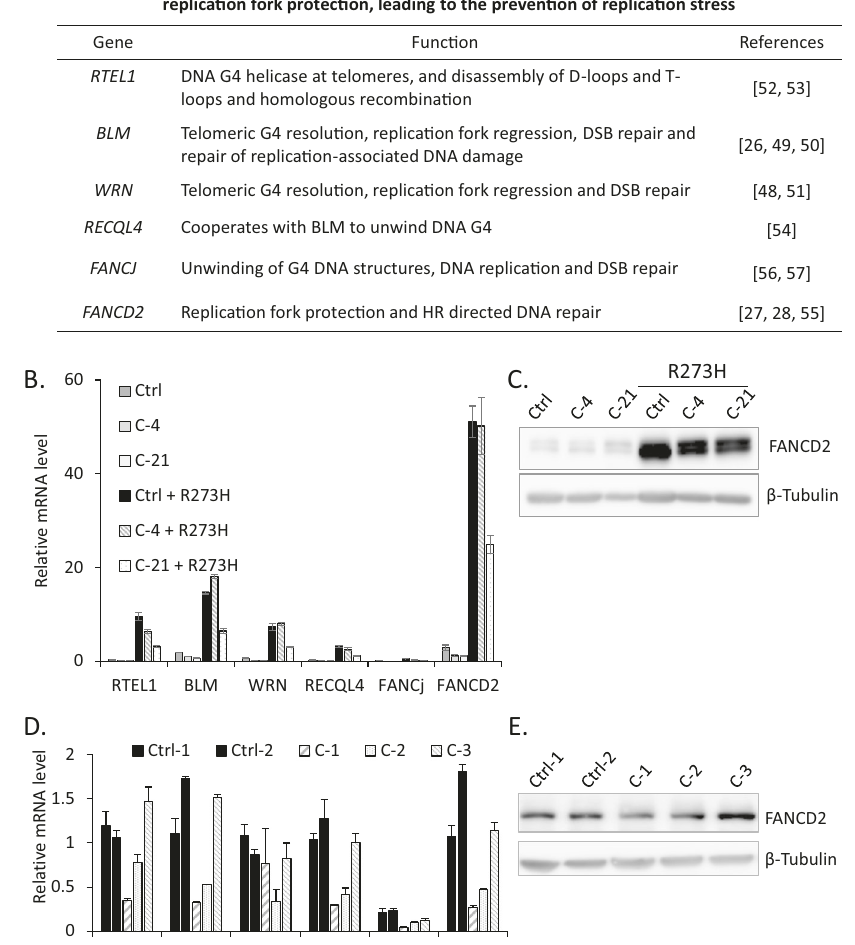
Fig. 5 p53 inactivation leads to the upregulation of G4-resolving helicases and FA pathway proteins involved in replication fork protection. A List of p53 downregulated G4-resolving eukaryotic helicases or FA pathway DNA repair molecules and their proposed biological functions during DNA replication. B A comparison of TP53 wt and p53-inactivated Ctrl or ATRX KO cells suggested the p53-dependent regulation of G4-resolving helicases and the FA pathway DNA repair molecule, FANCD2. Real-time RT-PCR analysis of RTEL1 , BLM , WRN , RECQL4 , FANCJ , and FANCD2 in the indicated samples. Relative expression normalized to GAPDH, mean ± SD ( n = 3). C p53 inactivation leads to increased FANCD2 protein levels. Protein extracts, prepared from TP53 wt and p53-inactivated Ctrl or ATRX KO NGP cells, were immunoblotted with antibodies against FANCD2 and β -Tubulin. D Real-time RT-PCR analysis of G4-resolving helicase genes and FANCD2 in Ctrl and ATRX KO SK-N-AS cells. Relative expression normalized to GAPDH, mean ± SD ( n = 3). E Western blot analysis of FANCD2 in Ctrl and ATRX KO SK-N-AS cells. β -Tubulin served as a loading